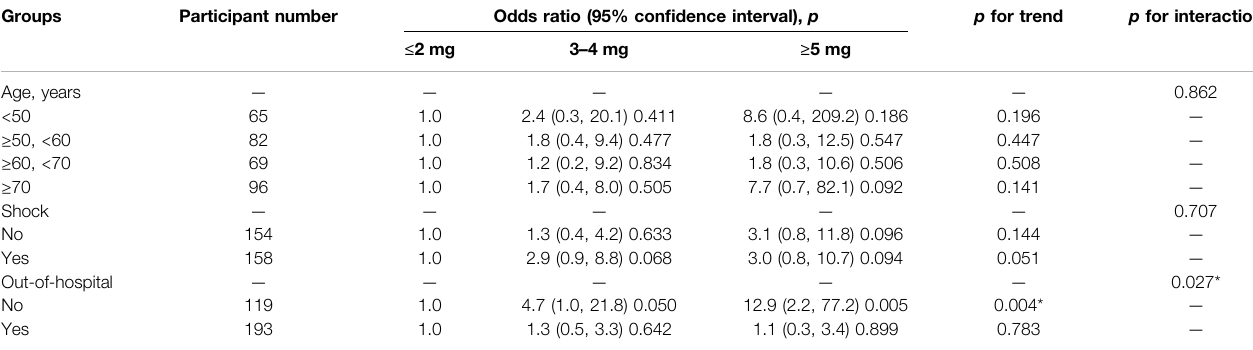
TABLE 4 | Subgroup